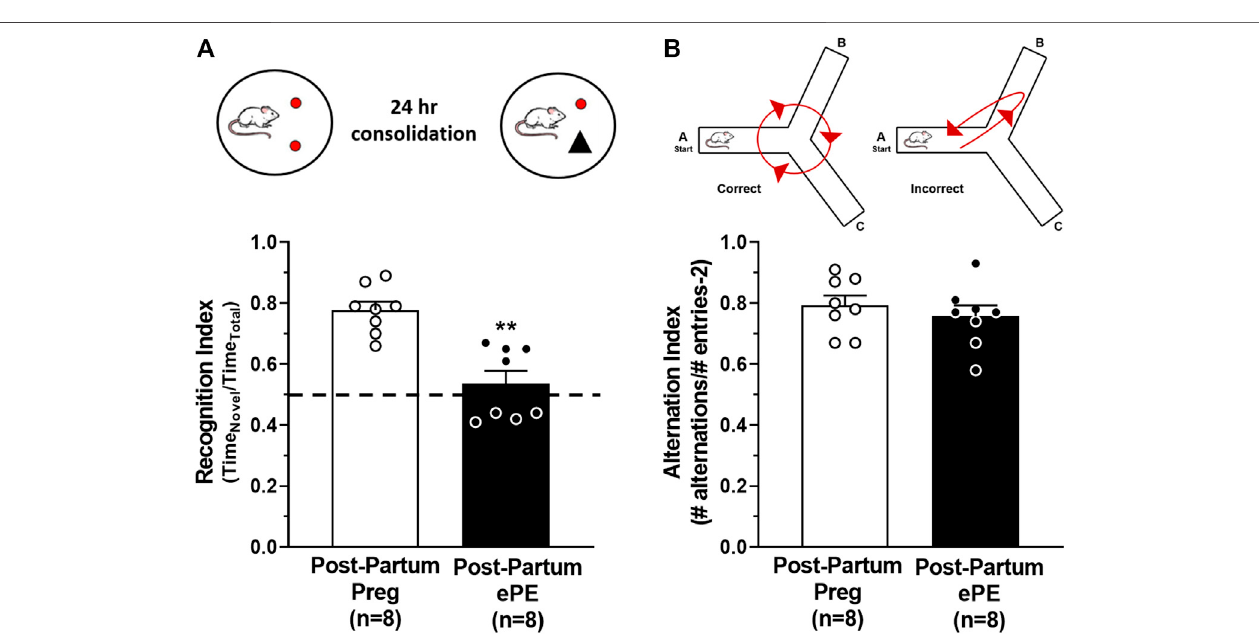
FIGURE1| Behavioralassessmentsofmemoryfunction5 monthsaftereitherahealthypregnancy(Post-PartumPreg)orexperimentalpreeclampsia(Post-Partum ePE). (A) Illustrationofthenovelobjectrecognition(NOR)taskparadigmconsistingofa24-hconsolidationperiodtoallowforassessmentoflong-termmemoryfunction. Recognition Index was decreased in Post-Partum ePE rats compared to Post-Partum Preg rats. (B) Illustration of the inherent spontaneous alternation behavior of cognitivelyintactrodentspreferringtoalternatebetweenYmazearms(left)andarmreversalsoccurringinerror(right)asanassessmentofspatialmemoryfunction. Alternation Index was similar between Post-Partum Preg and Post-Partum ePE rats. Data are mean ± SEM, ** p < 0.01 by Mann-Whitney test.